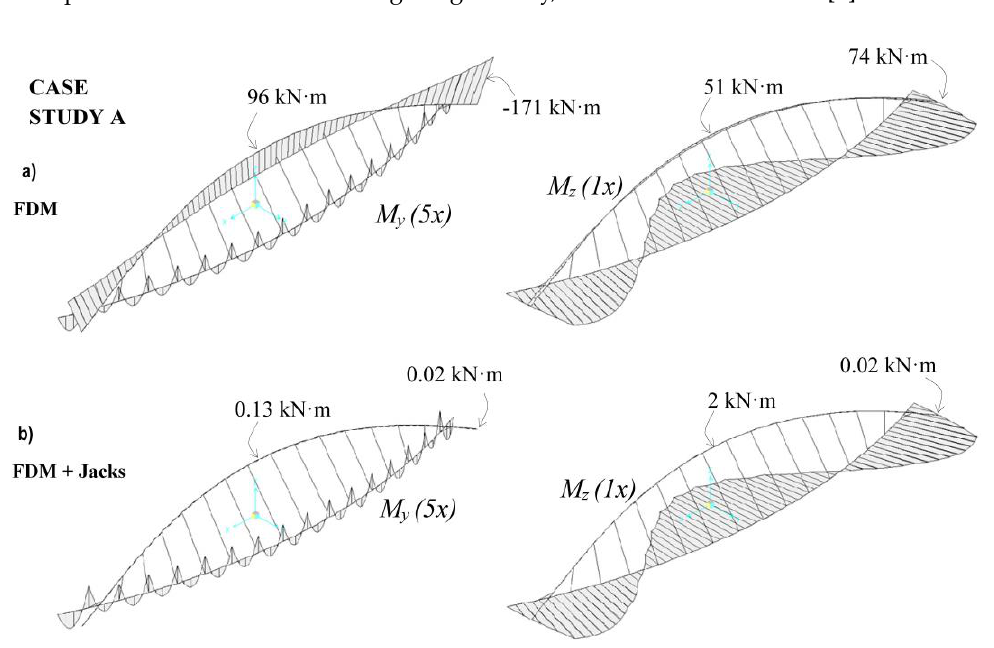
Figure 14. Bending moment at bridge for the case study A: ( a ) Results of FDM or SGSM. ( b ) Results of FDM + Jacks acting on springing points (or, alternatively, results of LEM or GRM).